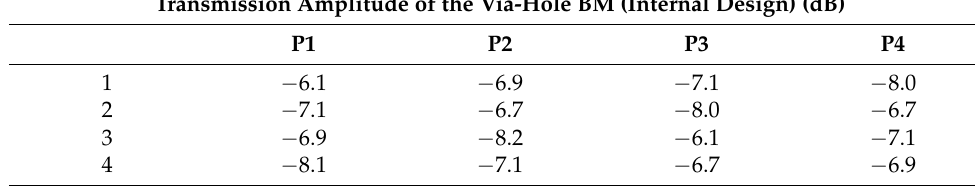
Figure 19. Output phase difference of the BM. Table 3 details the simulated transmission amplitude of the via-hole BM with balanced values with minimal average difference of 1.1 dB from the ideal value of − 6 dB, where the ideal value for transmission amplitude of − 6 dB is assumed lossless for the structure. The output phase difference of the theoretical and simulation is tabulated in Table 4, and the simulation results agree well with the theoretical value and have average errors of 4.7 ◦ from the ideal values. The measured 10 dB impedance bandwidth of the structure ranges from 26 to 30 GHz, which is equivalent to 14% of bandwidth. The size of the structure is 2.17 λ 0 × 2.69 λ 0 at the center frequency of 28 GHz. The internal structure of the BM and the new structure with extension strip line, ∆ L , with input ports (1–4) and output ports (5–8) is illustrated in Figure 20. The final design of BM that includes the additional strip line has a new dimension of 100 mm × 82.5 mm, equivalent to 9.34 λ 0 × 7.7 λ 0 at the center frequency of 28 GHz. Table 3. Simulated transmission amplitude of the via-hole BM in dB. Transmission Amplitude of the Via-Hole BM (Internal Design) (dB) P1